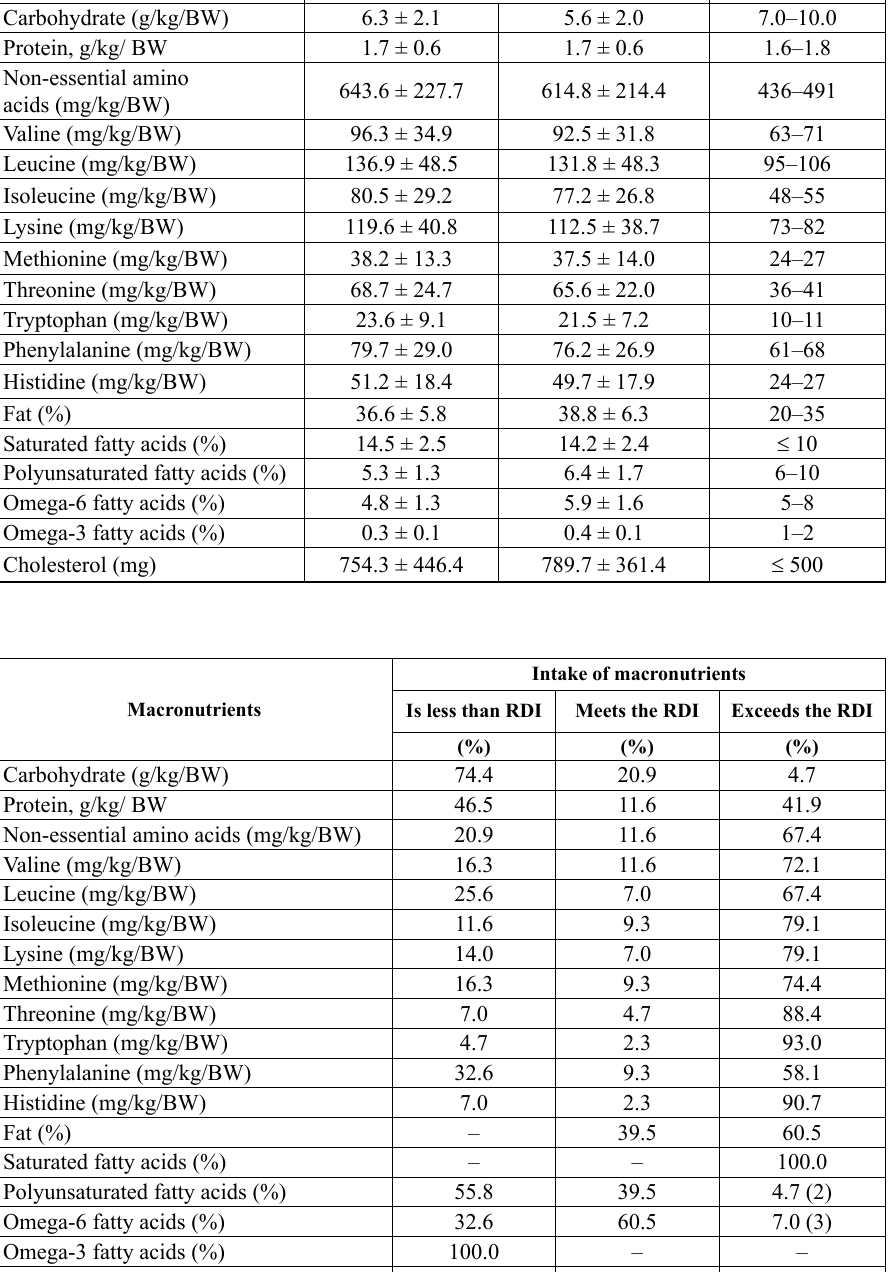
Table 3. Macronutrient in- take of combat sports ath